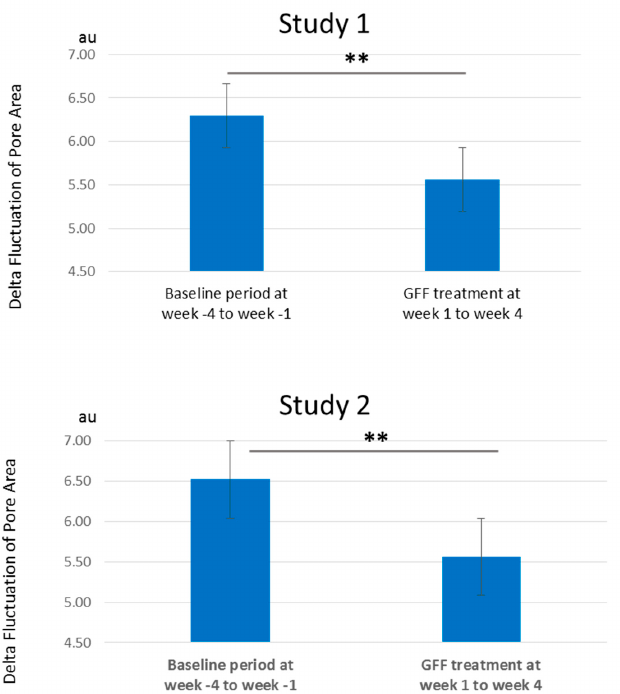
Figure 6. Delta fluctuation of pore area. Delta fluctuation of the pore area is significantly ameliorated by GFF treatment from week 1 to week 4 compared with baseline period from week -4 to week -1. **: p < 0.01.